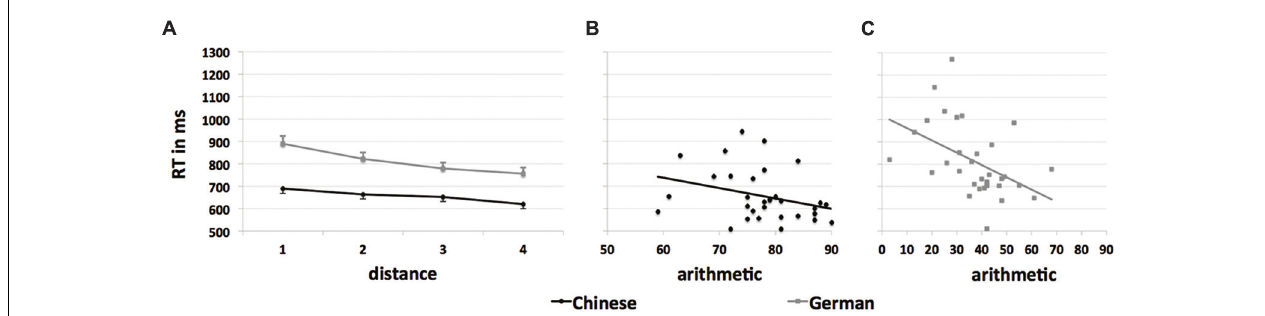
FIGURE 1 | Reaction times (RT in ms) for correct responses in the symbolic numerical magnitude comparison task and correlations with the performance in the arithmetic tasks. (A) RT separately for Chinese and German children as a function of the factor distance (1, 2, 3, 4). (B,C) Correlations between the performance in the arithmetic tasks (raw score totals, theoretical range: 0–90) and mean RT in the symbolic numerical magnitude comparison task separately for Chinese and German children.